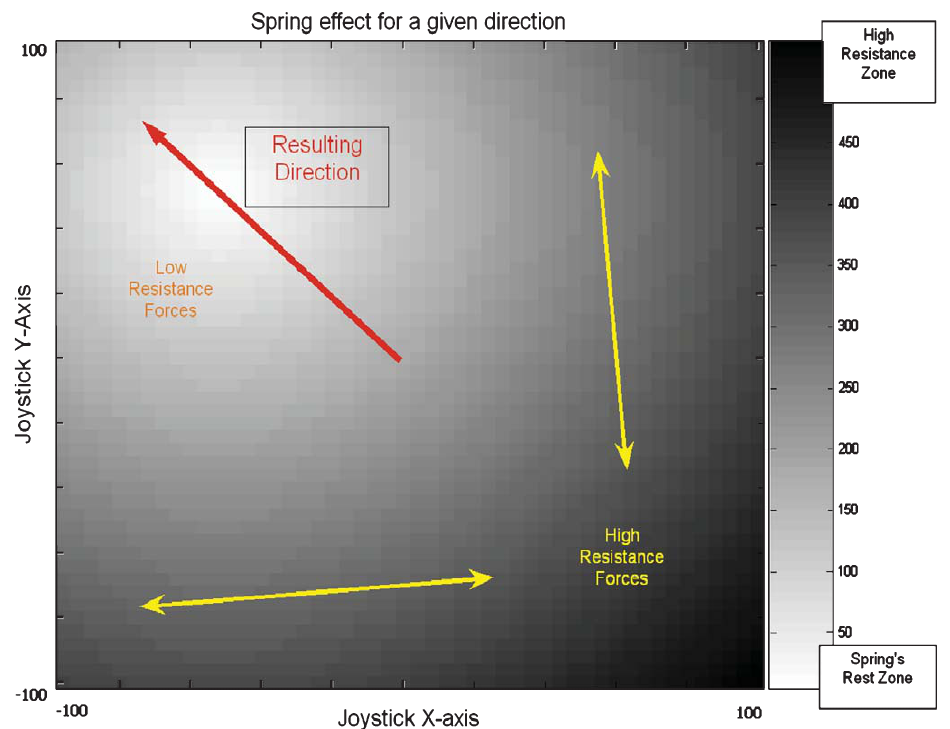
Fig. 5. Example of force application in the active